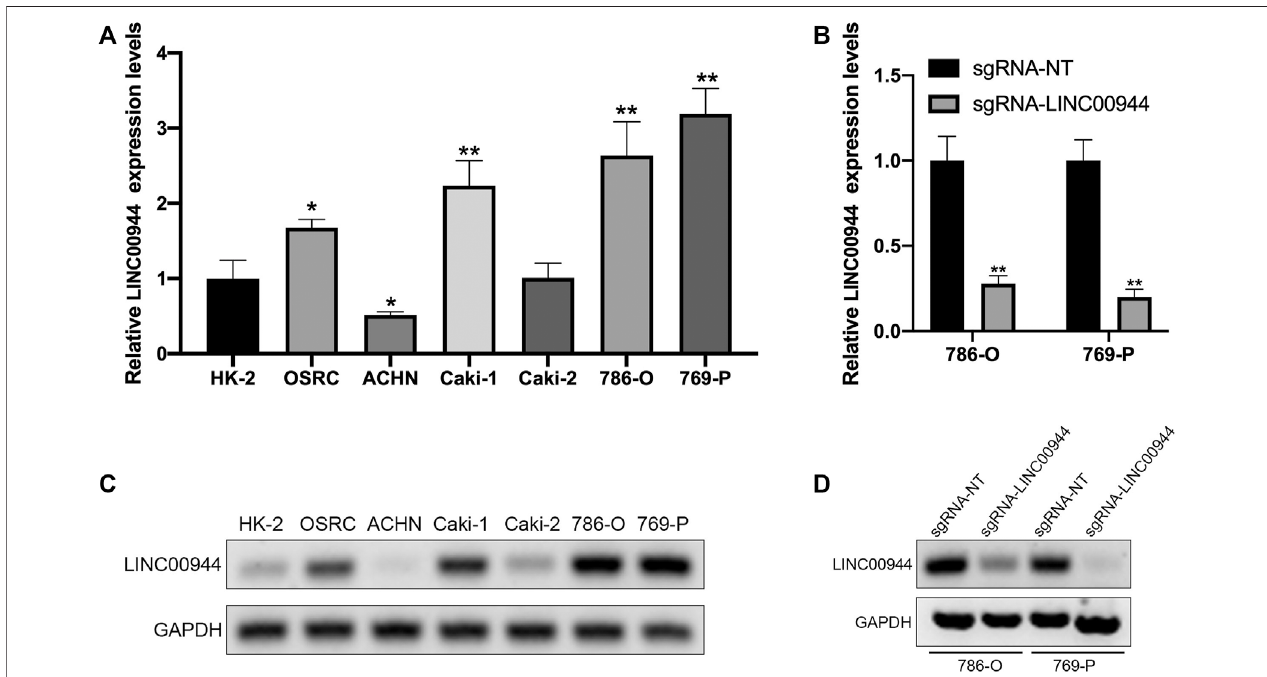
FIGURE 2 | CRISPR/dCas9-KRAB decreased the expression level of LINC00944 in RCC cells. (A,C) Expression levels of LINC00944 in RCC cell lines (OSRC, ACHN, Caki-1, Caki-2, 786-O, and 769-P) and normal renal tubular epithelial cell line (HK-2) by qRT-PCR and semi-quantitative RT-PCR. (B,D) Expression levels of LINC00944 in 786-O and 769-P RCC cells transfected with dCas9-KRAB and sgRNA-NT or sgRNA-LINC00944 for 24 h by qRT-PCR and semi-quantitative RT-PCR. * p < 0.05; ** p <